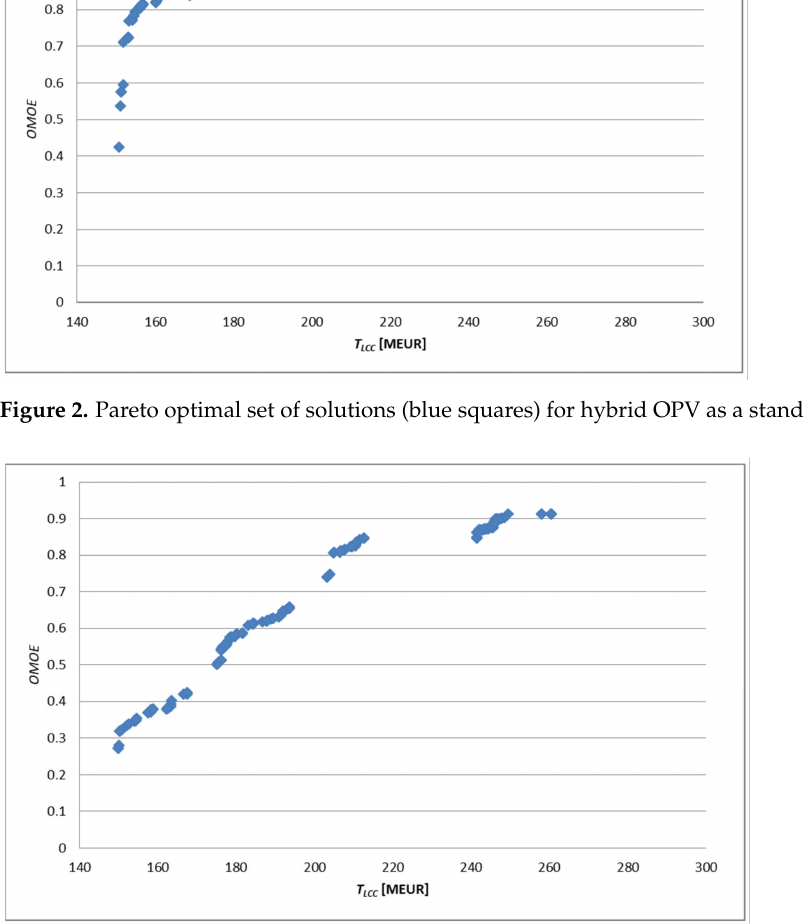
Figure 3. Pareto optimal set of solutions (blue squares) for hybrid OPV as a combat